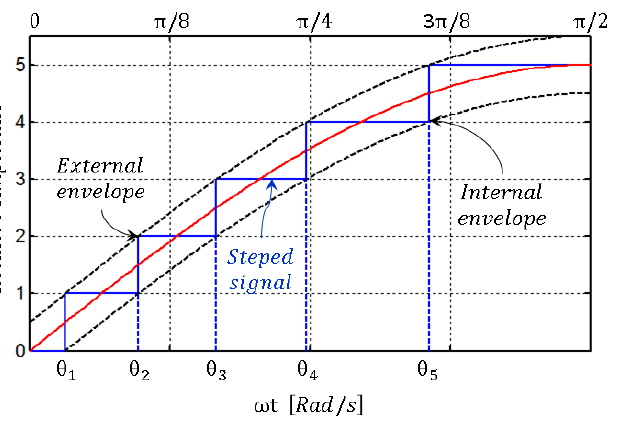
Figure 2. A quarter of cycle of a multilevel signal showing relation of time intervals with external and internal envelopes.